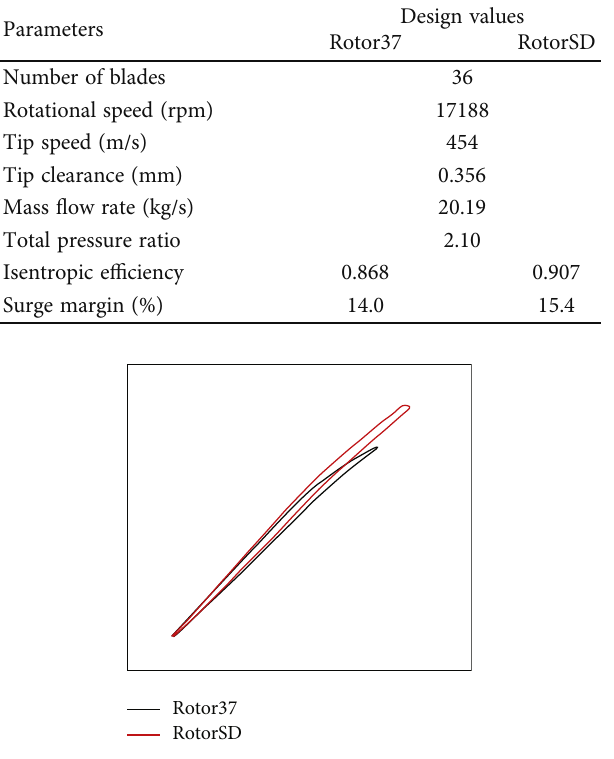
Figure 1: Comparison of the geometry of the two rotors at 90% span.